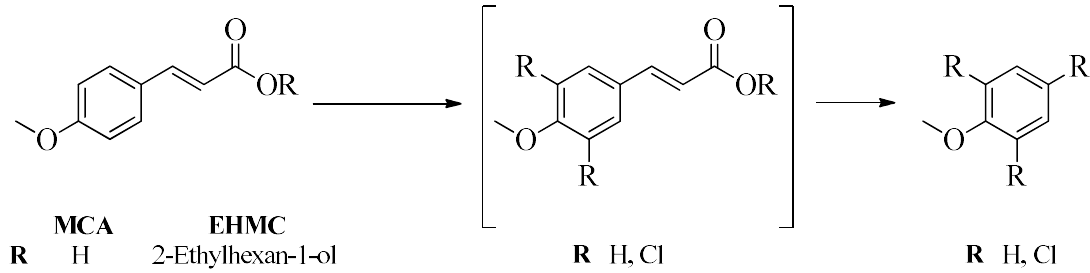
Figure 7. Chemical filters derived from cinnamic acid and possible reactive sites.